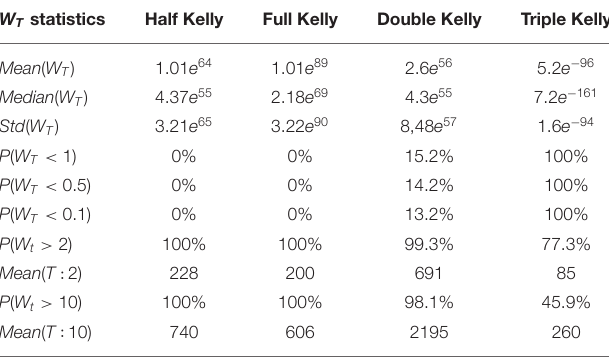
TABLE 4 | Results after 40,000